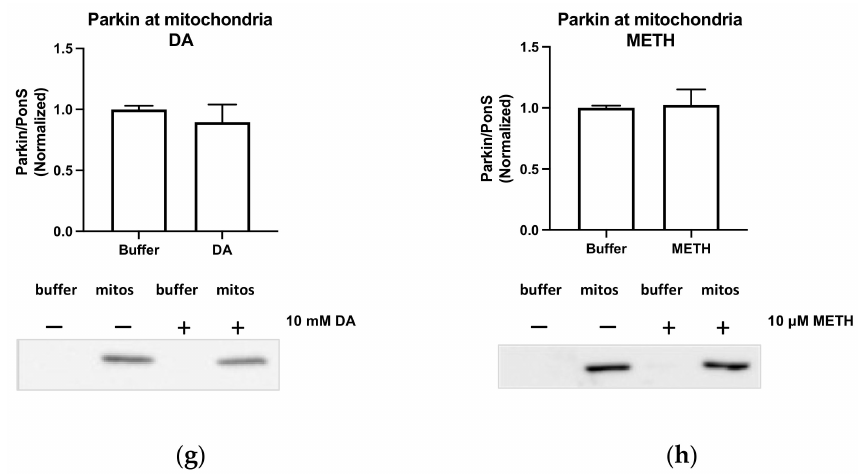
Figure 7. ( a – d ) Effects of increasing doses of DA on the levels of parkin in the ( a , c ) cytoplasmic and ( b , d ) mitochondrial fraction. High doses of DA significantly decreased parkin immunoreactivity in the cytoplasmic fraction while increasing it in the mitochondrial fraction under reducing conditions. Under nonreducing conditions ( c , d ), high DA doses caused aggregation of parkin in the mitochondrial fraction. ( e ) Total levels of parkin showed a trend toward statistical significance for a decrease. ( f ) The 10 µ M METH decreased parkin immunoreactivity in the mitochondrial fraction but not in the cytoplasmic fraction. ( g , h ) The effects of 10 mM DA ( g ) or 10 µ M METH ( h ) on the levels of parkin in isolation-buffer-suspended striatal mitochondria. * p < 0.05, ** p < 0.01, *** p < 0.001, one-way ANOVA with Dunnett’s post hoc